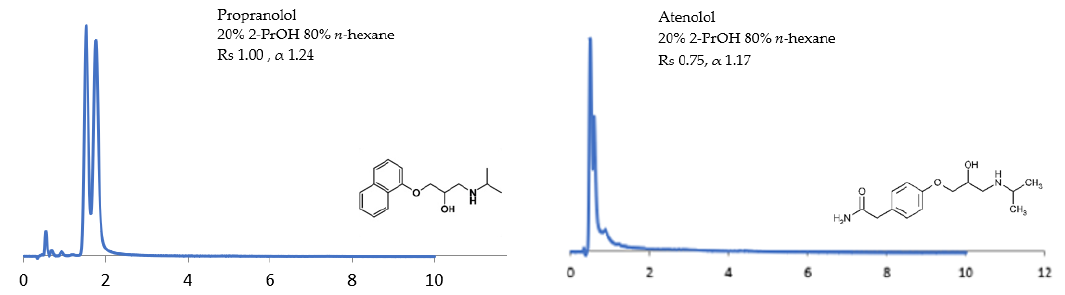
Figure 4. The effect of 20% 2-propanol (2-PrOH) on the stereoselective interactions of β -blockers.